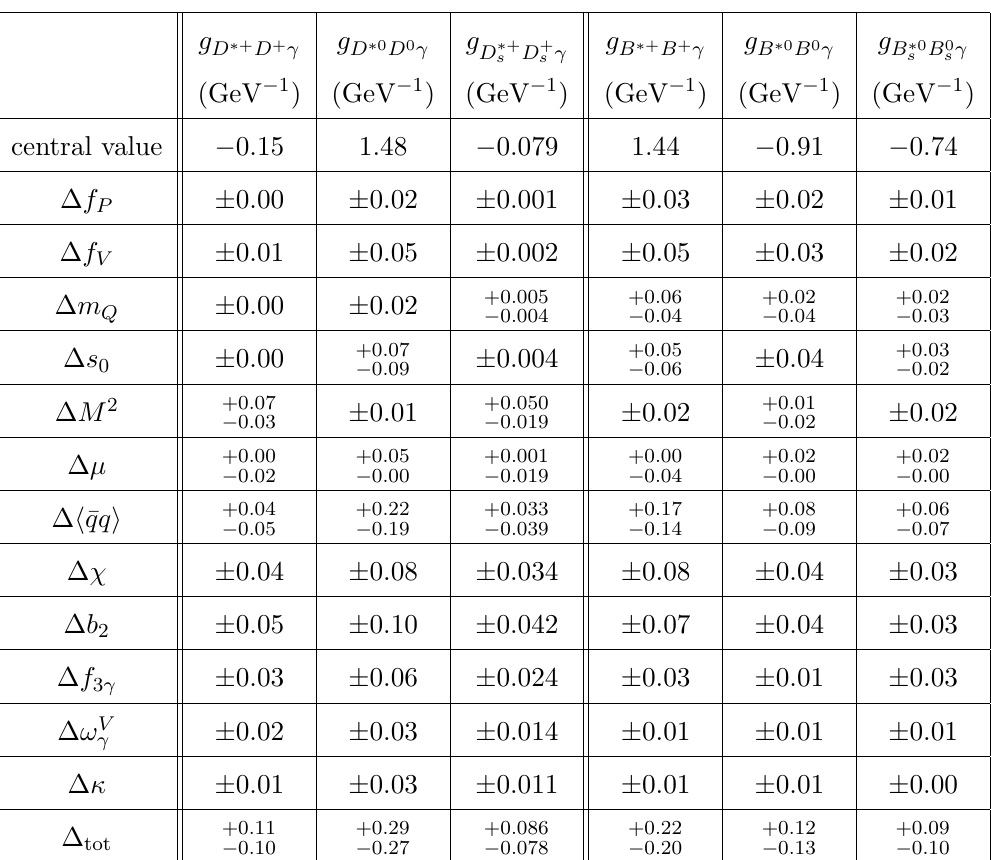
Table 3 . Summary of the individual theory uncertainties for the heavy meson magnetic couplings M (cid:3) M(cid:13) predicted from the LCSR (4.19). The negligibly small uncertainties due to variations of the remaining input parameters are not displayed here explicitly, but are already taken into account in the determinations of the total errors (cid:1) tot